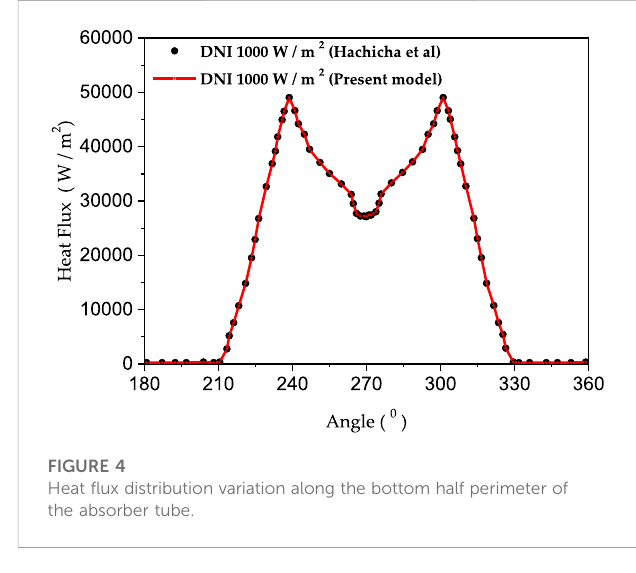
FIGURE 4 Heat fl ux distribution variation along the bottom half perimeter of the absorber